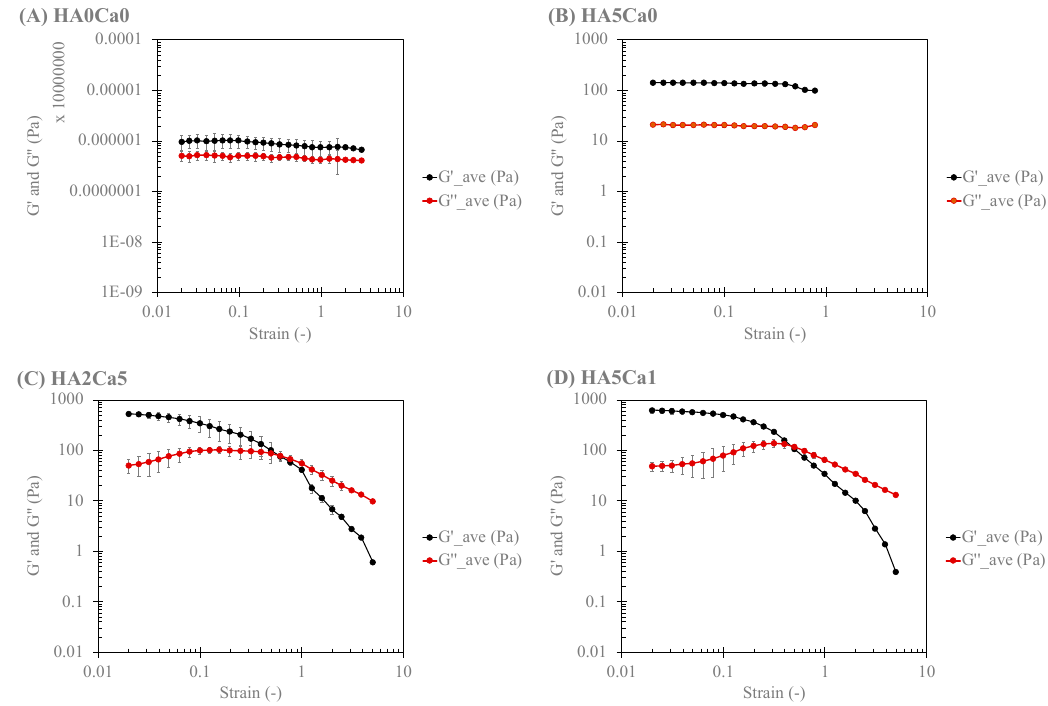
Figure 6. Amplitude (strain) dependence of four systems: System 1: ( A ) chitosan/collagen hydrogel alone; System 2: ( B ) hydrogel with 5% nHA; System 3: ( C ) hydrogel with 2% nHA and 5% CaCO 3 ; and System 4: ( D ) hydrogel with 5% nHA and 1% CaCO 3 . Table 1. Rheological parameters for the strain sweep test at the one hertz frequency of the hydrogels. Sample